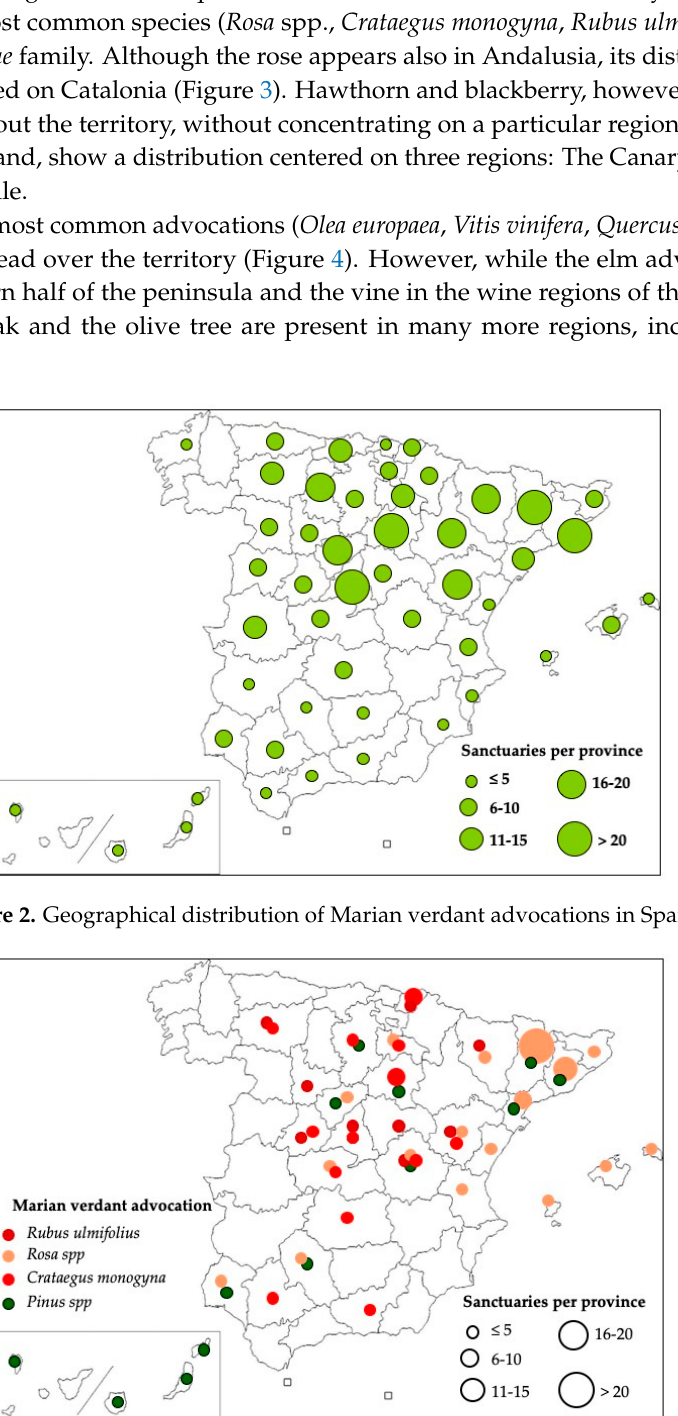
Figure 3. Geographical distribution of Rubus ulmifolius , Rosa spp., Crataegus monogyna , Pinus spp.